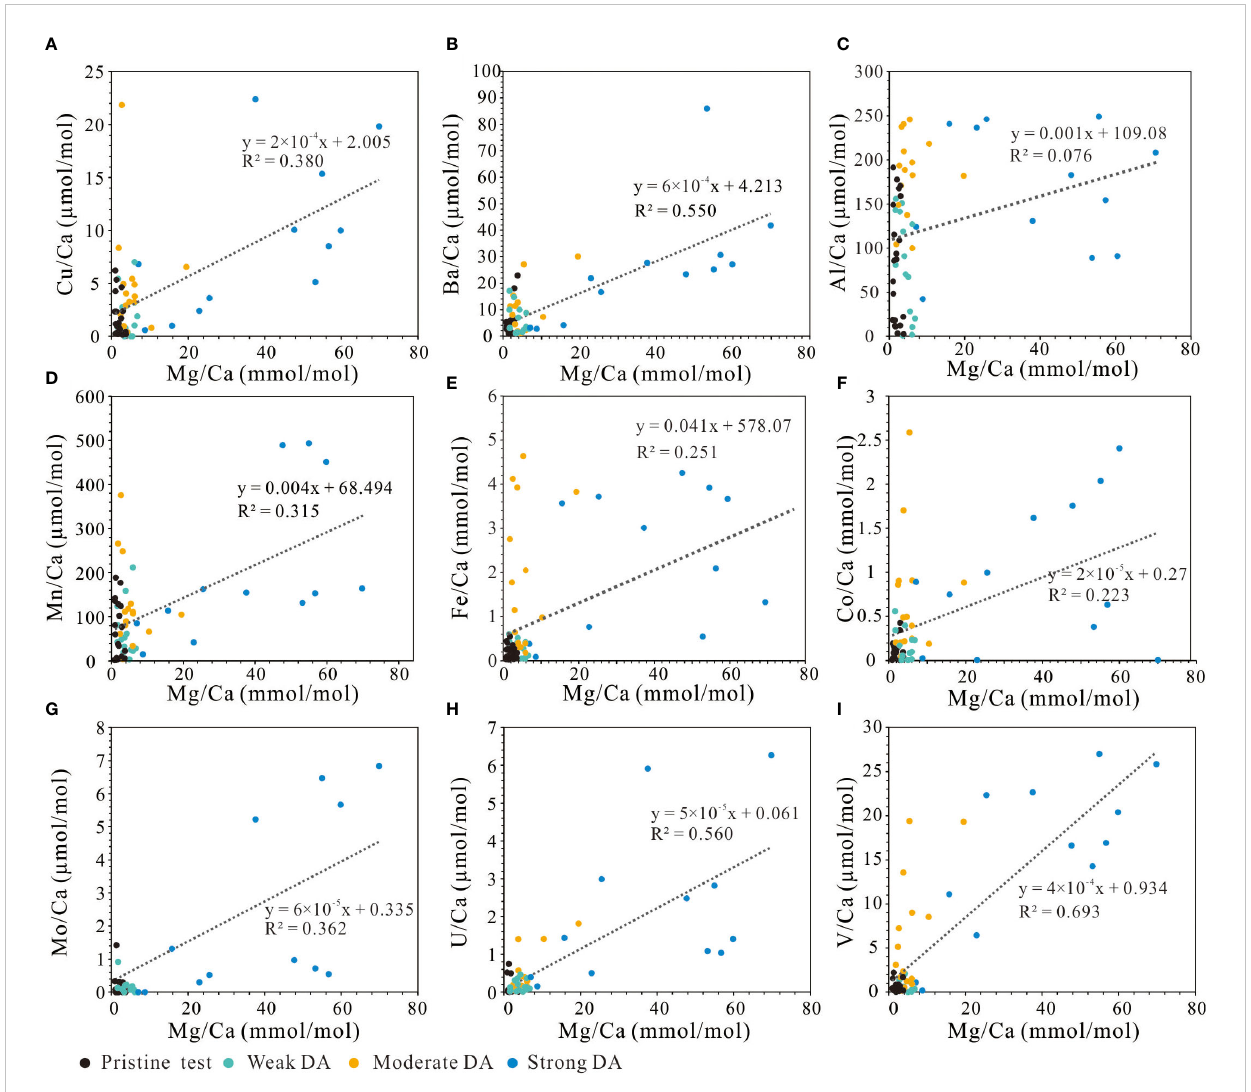
FIGURE 8 (A – I) Correlations of LA-ICP-MS foraminiferal elemental ratios. The samples are coded according to diagenetic alteration stage: pristine (black), weakly altered (green), moderately altered (orange), and strongly altered